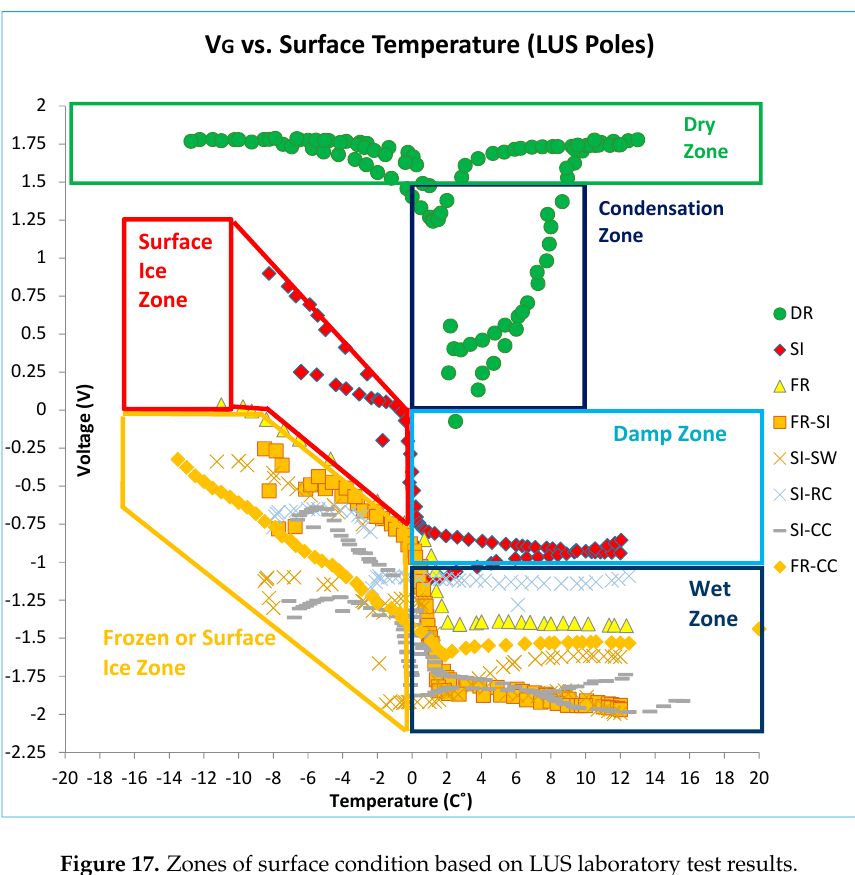
Figure 17. Zones of surface condition based on LUS laboratory test results. Sensors 2017 , 17 , 2912